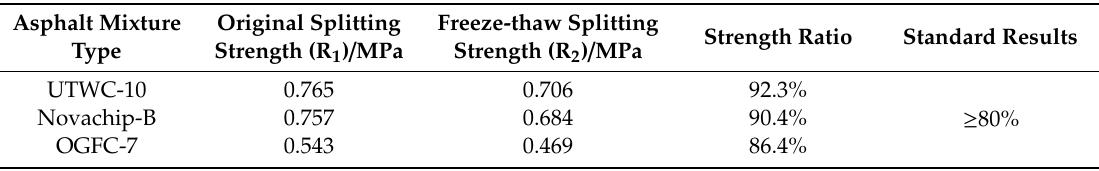
Table 7. Freeze-thaw splitting test results of three asphalt mixtures.